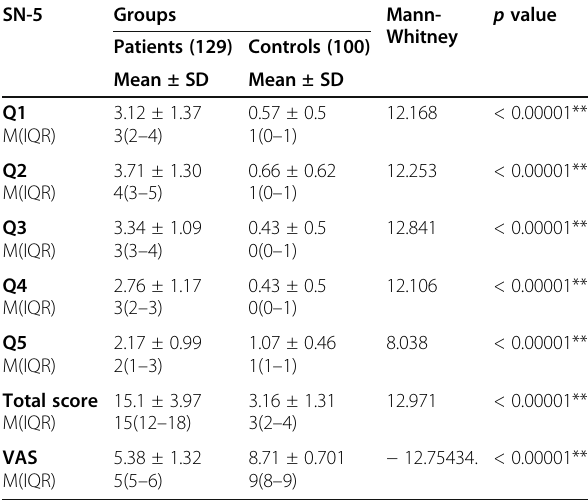
Table 4 Comparison between controls and patients regarding SN-5 questionnaire